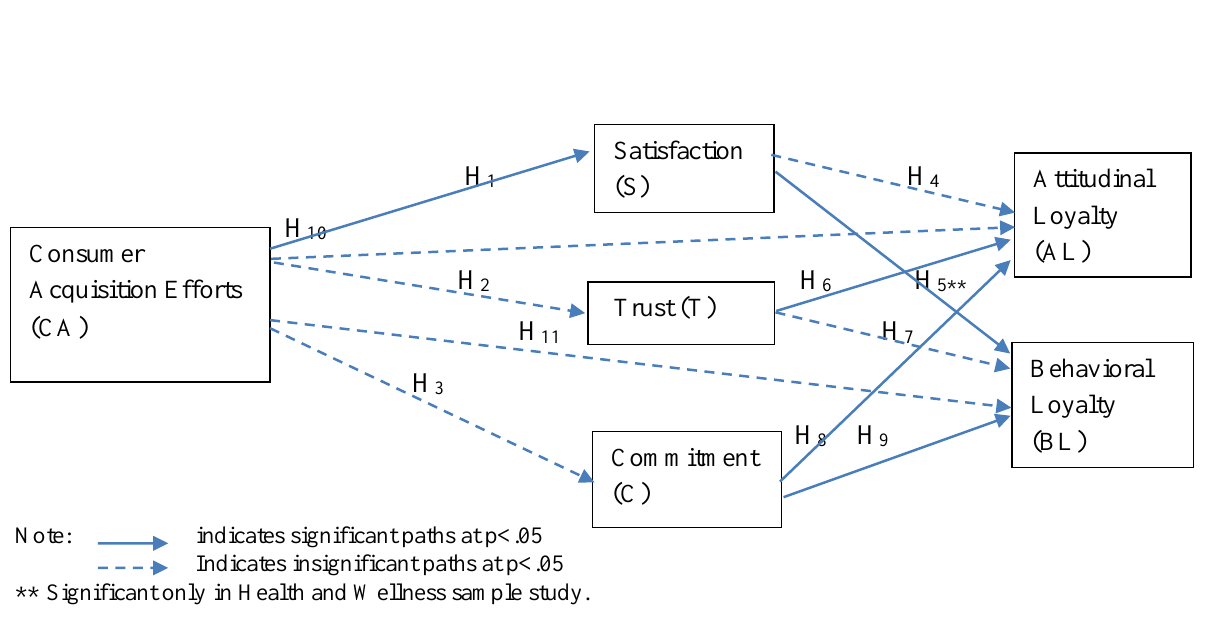
Figure 02: Structural Model showing Acceptance and Rejection of Proposed